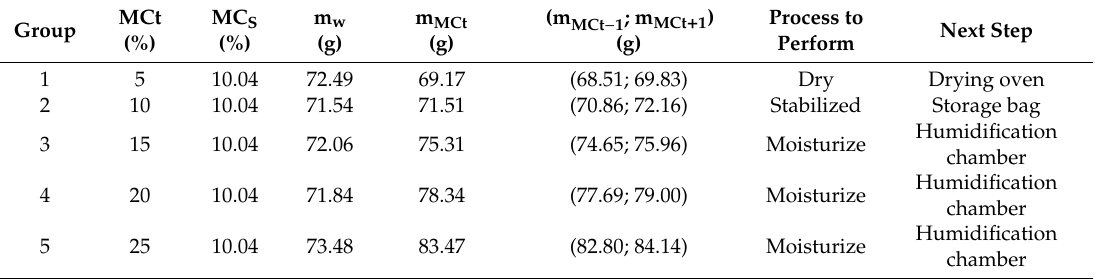
Table 2. Example of the process of obtaining moisture content (MCt) for a Western red Cedar specimen of each moisture content